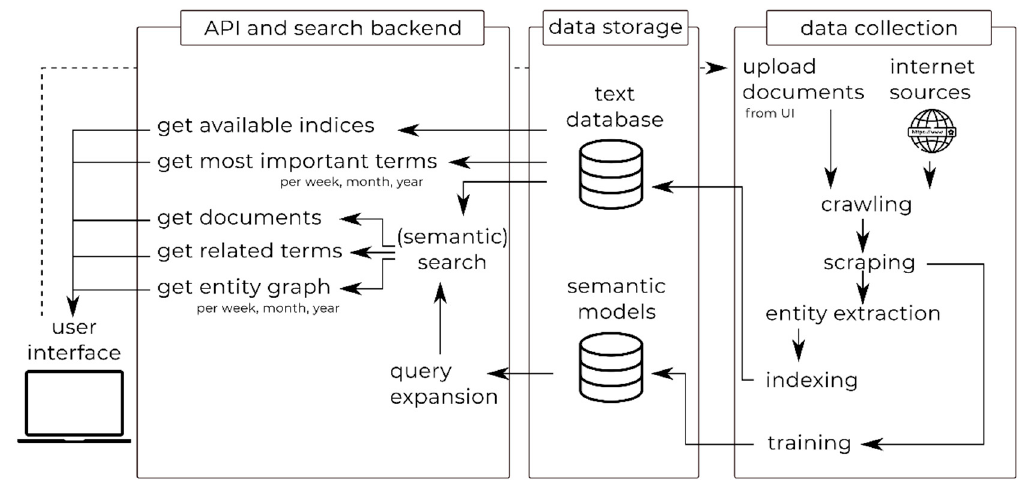
Figure 1. Overview of the Horizon Scanner Tool.